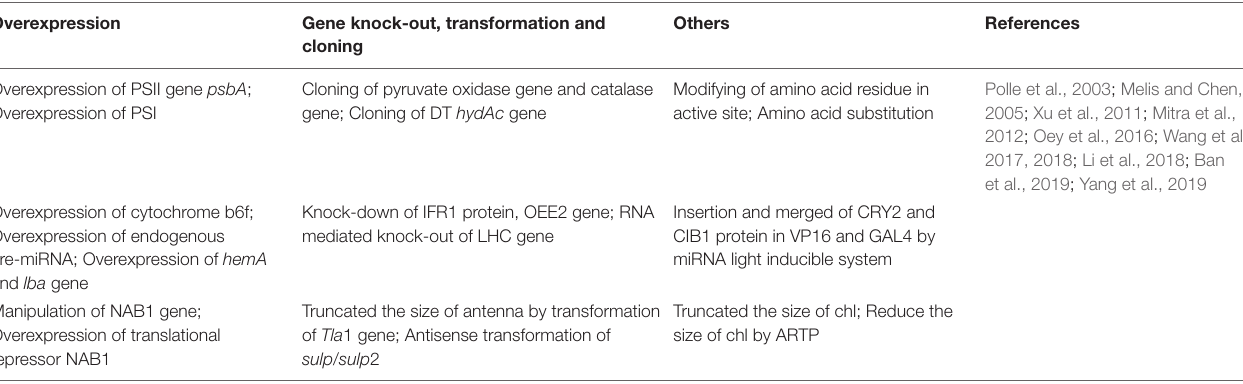
TABLE 2 | Various genetic engineering approaches to improve hydrogen yield in microalgae which mainly includes (a) Truncated the size of chlorophyll; (b) Overexpression of LHCs, hydA , lba gene; (c) Insertion of inducible gene psbA ; (d) Insertion of sulp gene, pruvate carboxylase. Overexpression Gene knock-out, transformation and